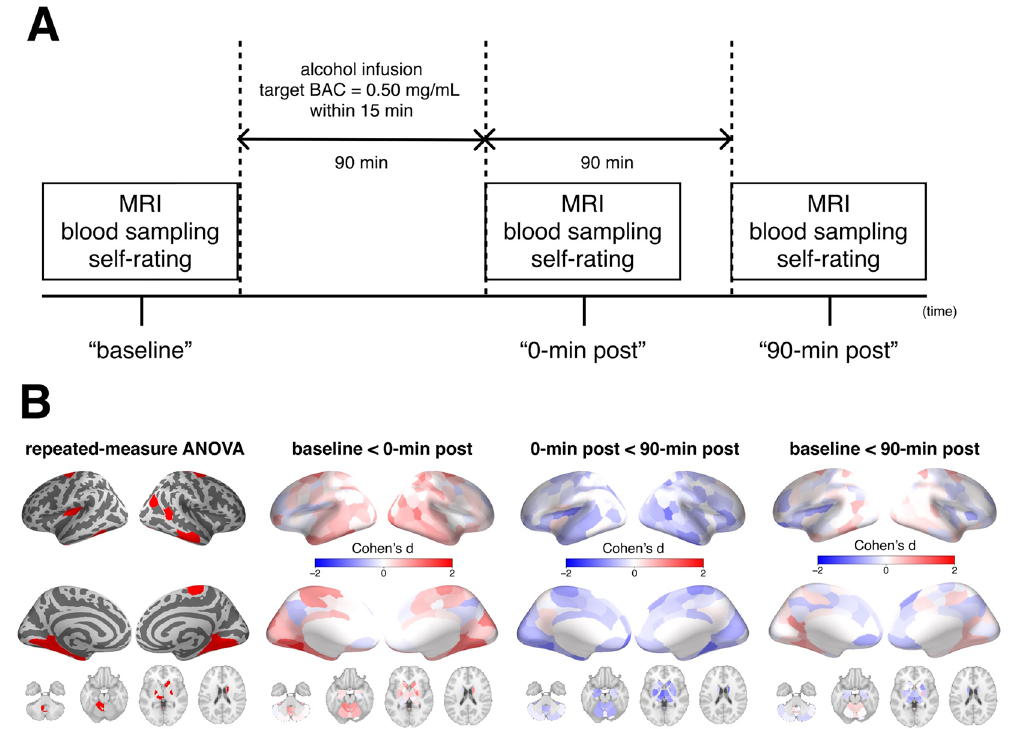
Figure 1. Experimental design and the effect on functional connectivity. Panel ( A ) represents the experimental design of the present study. Panel ( B ) represents differences of log-transformed local functional connectivity density across the conditions. The leftmost column of the panel shows regions which have significant differences across the conditions revealed by repeated-measure ANOVA. The others show regional effect sizes (Cohen’s d) of the differences of log-transformed local functional connectivity density between the conditions. These maps are visualized using pysurfer (0.10) (https:// github. com/ nipy/ PySur fer). ANOVA analysis of variance, BAC blood alcohol